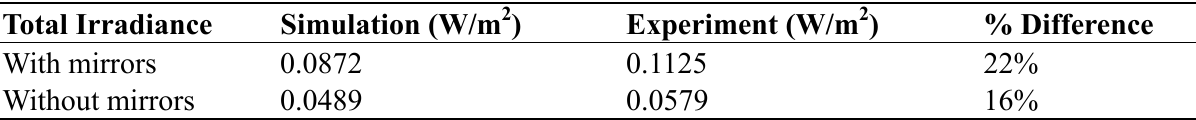
Table 3. Comparison of total irradiance from simulation result and experimental